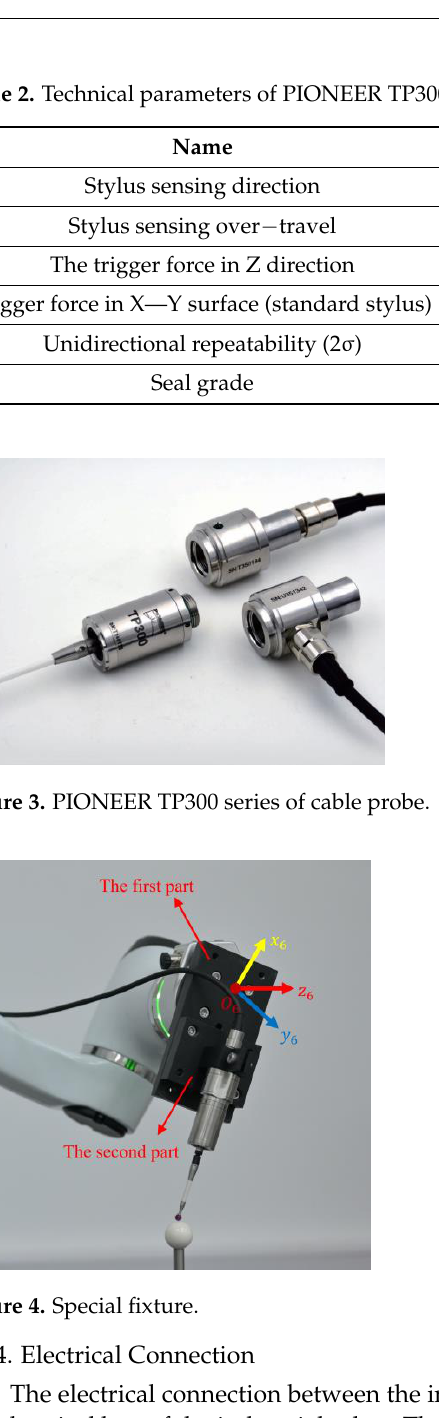
Figure 4. Special fixture.